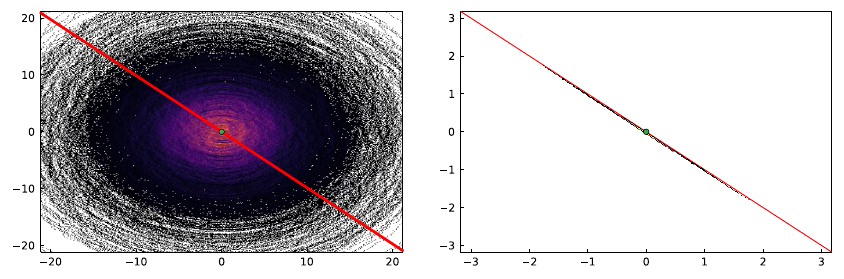
Figure 1 . Distribution of a complex Langevin simulation (scatter points) and the Lefschetz thimble (red line) for the model eq. (3.1). (left) simulation according to the naive CL eq. (3.2) and (right) simulation after introducing the kernel in eq. (3.6). The color of the scatter points refers to the number of measurements recorded at the corresponding position, a lighter color indicates a larger number. Note that the optimal kernel has moved the sampling onto the single thimble present in this simple